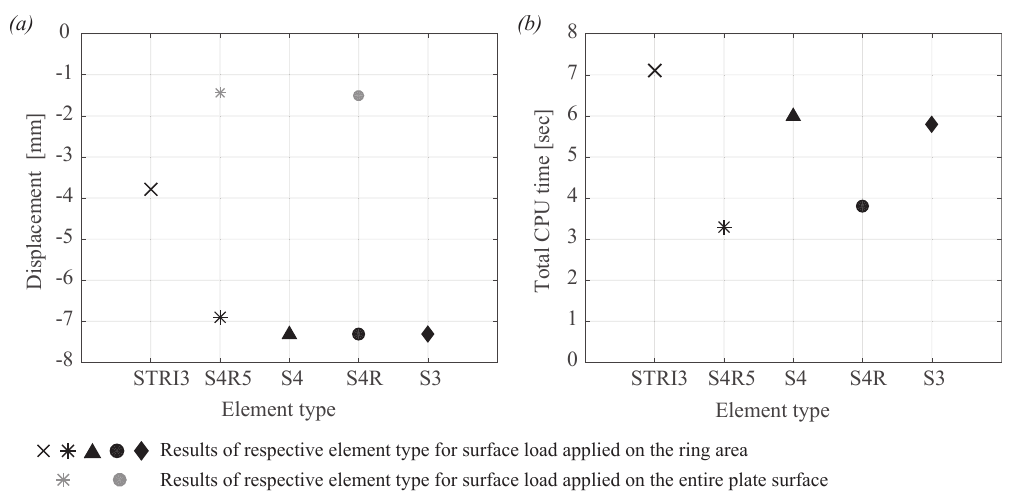
Figure A1. Element type vertical displacement results for one isolated triangular plate under 5kN/surface area load and clamped boundary conditions ( a ). Total computation time needed for the analysis ( b